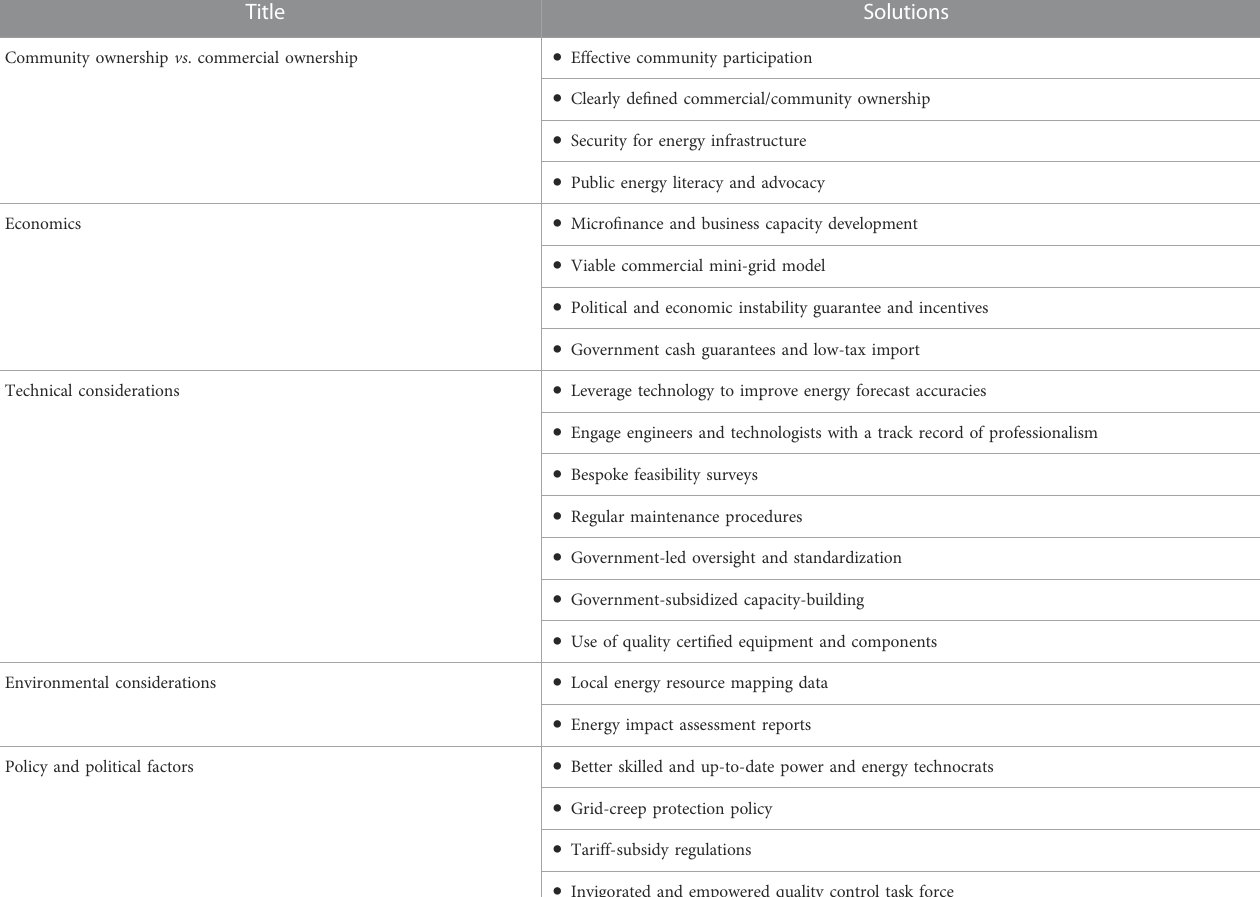
TABLE 7 Challenges to mini-grid developments in Sub-Saharan Africa and corresponding solutions (Peters et al., 2019; Boait,